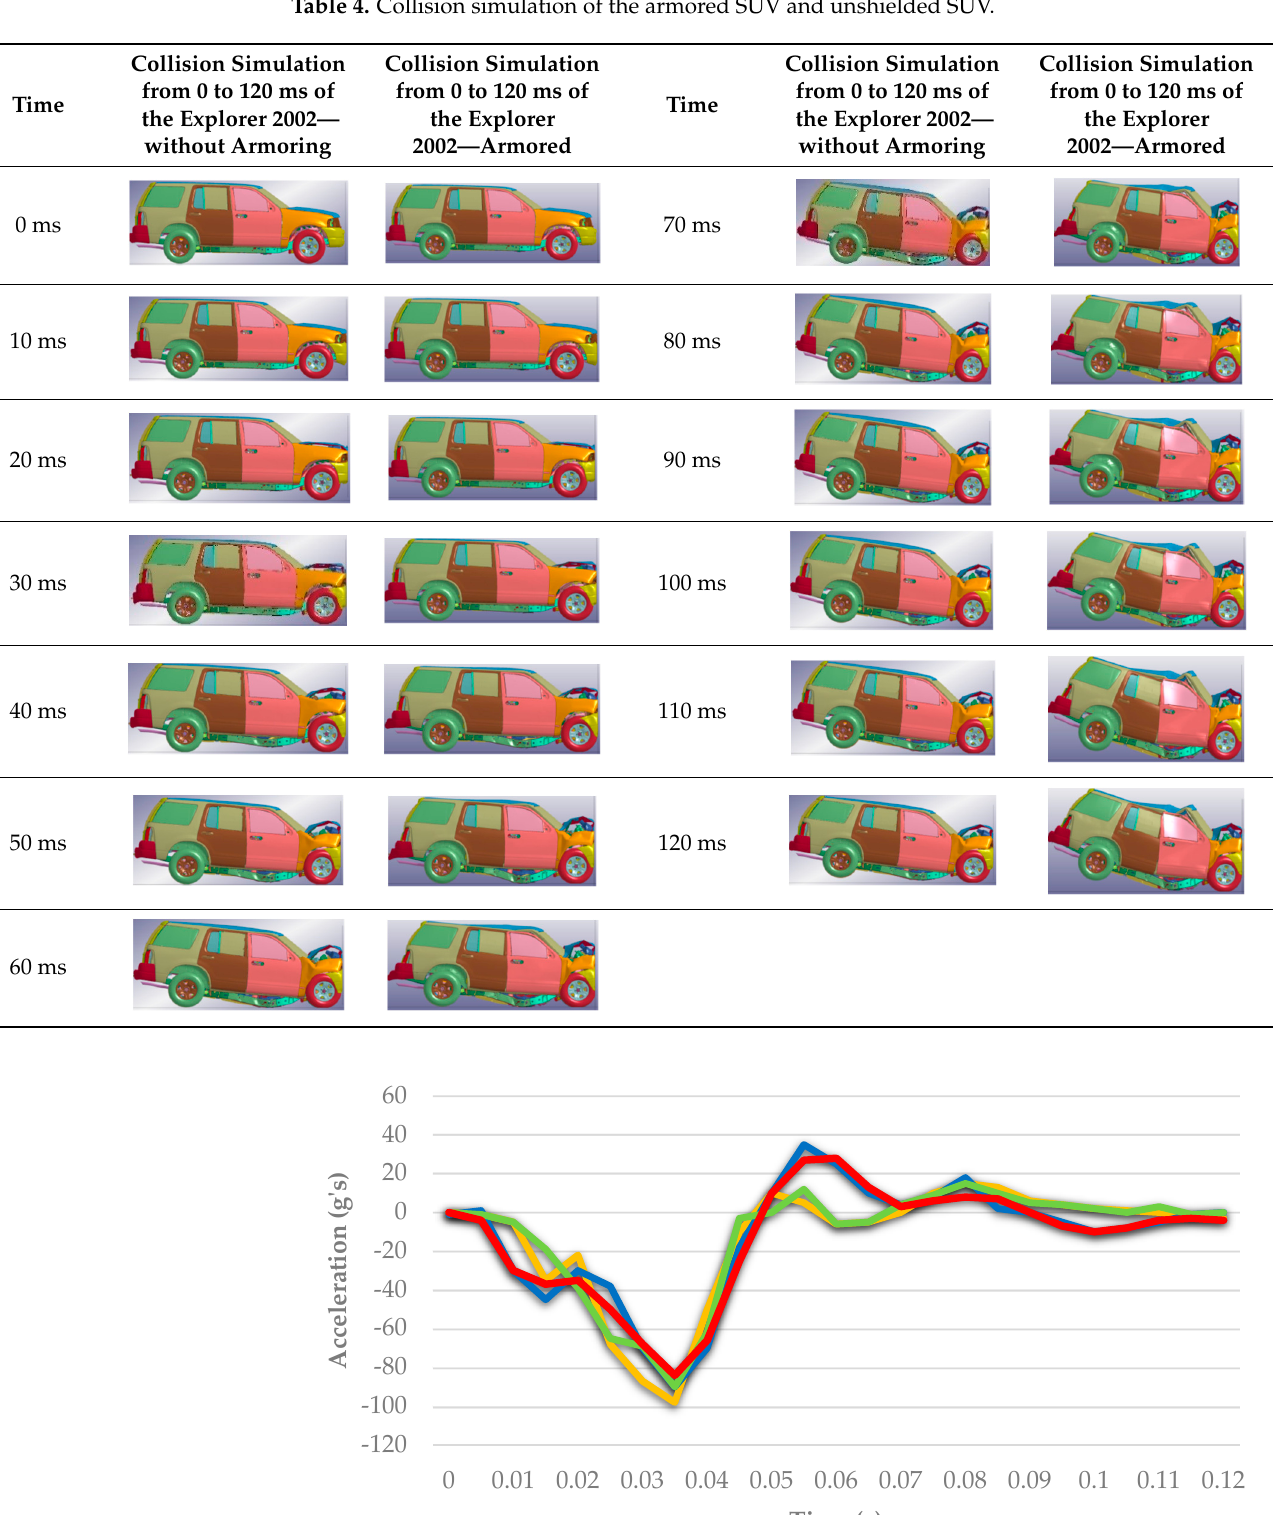
Table 4. Collision simulation of the armored SUV and unshielded SUV.